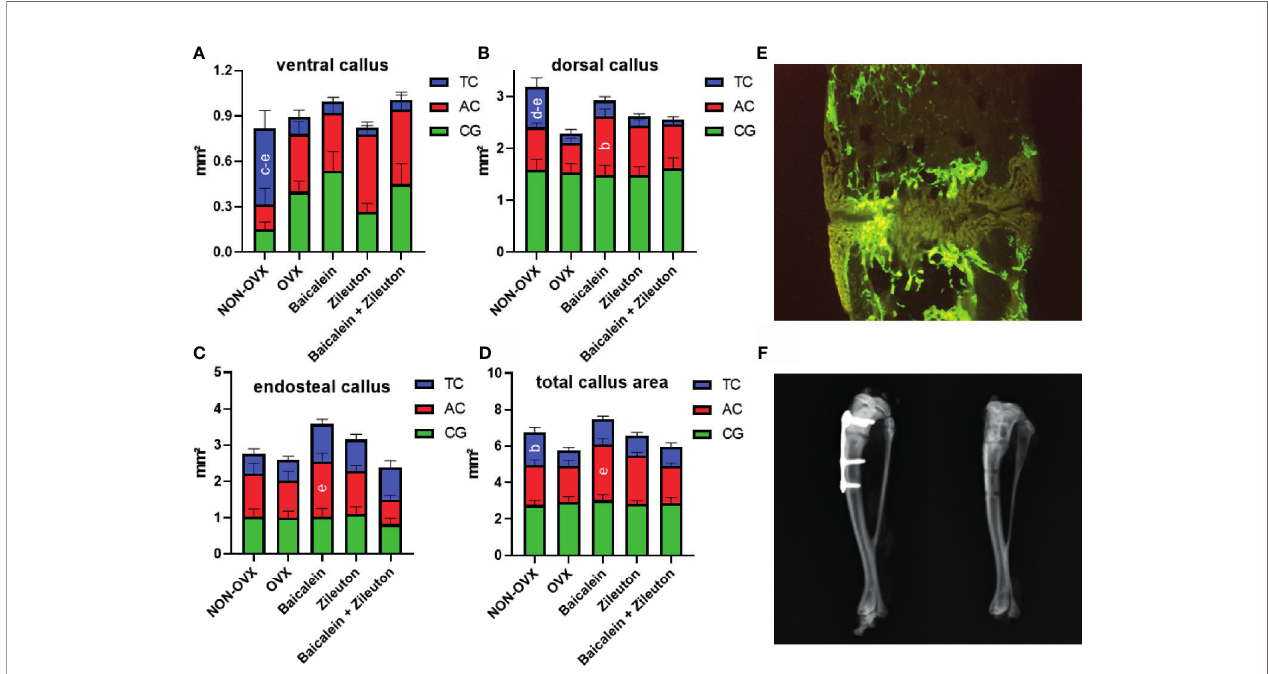
FIGURE 2 | Tibia healing analysis. Ventral callus area (A) , dorsal callus area (B) , endosteal callus area (C) and total callus area (D) stained with fl uorochromes XO+CG (0-19d after osteotomy), AC (20-27d after osteotomy) and TC (28-33d after osteotomy) and measured on histological sections (E) . X-rays prove the correct positioning of the plate after tibial osteotomy and healing is con fi rmed after plate removal (F) . [NON-OVX: n=8; OVX: n=10; Baicalein: n=9; Zileuton: n=11; Baicalein + Zileuton: n=11 (3 histological sections per animal)]. b Differs from OVX. c Differs from Baicalein. d Differs from Zileuton. e Differs from Baicalein+Zileuton (p <